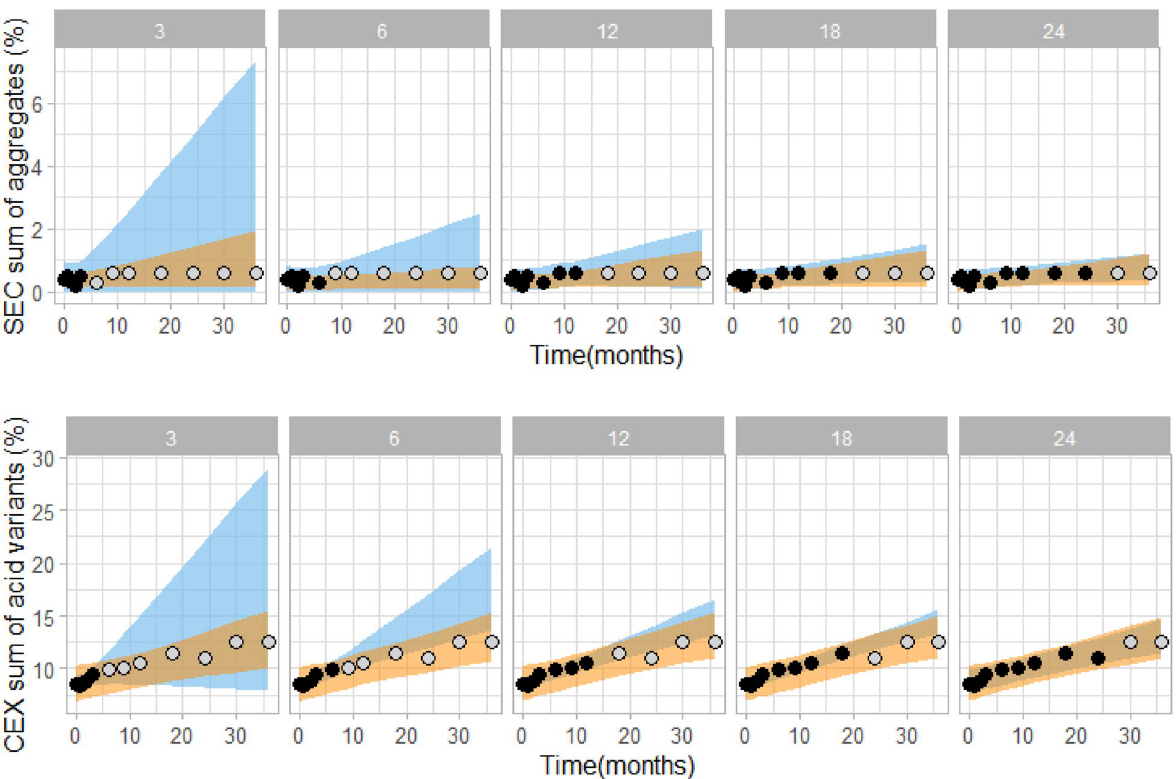
Figure 5. Comparison of kinetic model (orange) and linear extrapolation (blue) prediction intervals by using 3, 6, 12, 18 or 24 month experimental stability data (black data points). In grey, remaining measured data points at intended storage are shown for visual verification of the prediction intervals. Data shown is for one rituximab batch stored at 5 °C. For kinetic modelling data points from 25 and 40 °C conditions up to the respective time point were used (data points not shown for clarity